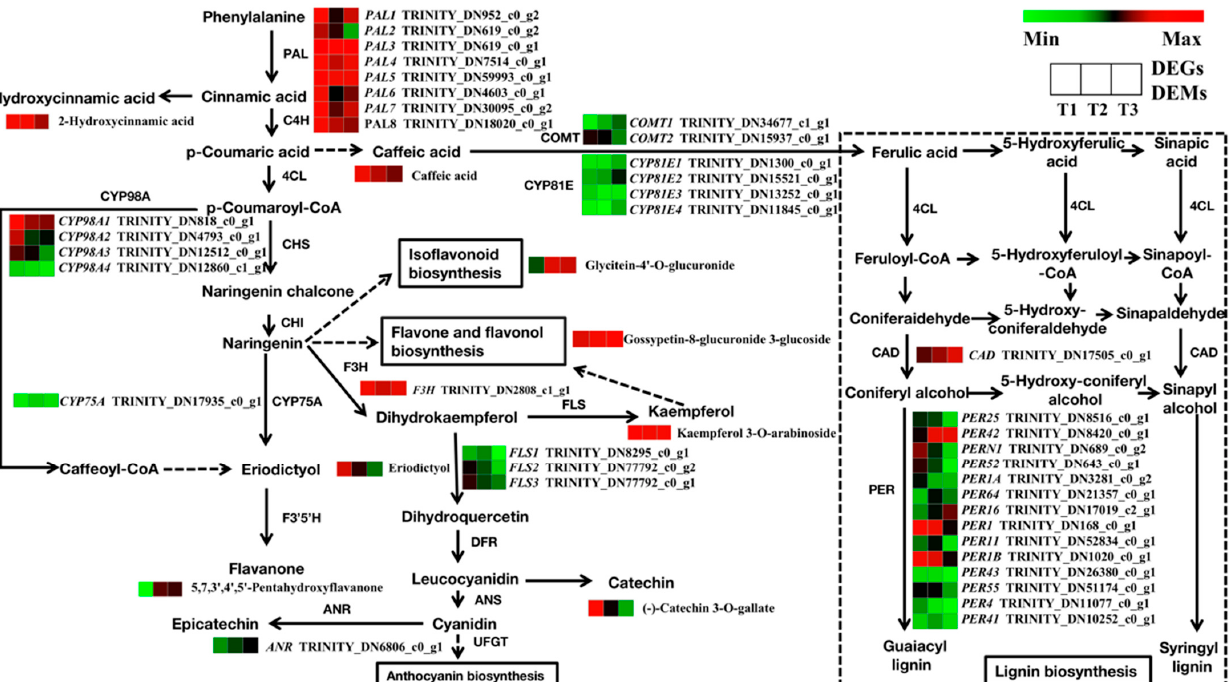
Figure 9. Regulatory network of flavonoid and phenylpropanoid biosynthesis in three different root samples. The color scale from green to red for the heatmap represents downregulated and upregu- lated expression. PAL, phenylalanine ammonia lyase; F3H, flavanone 3-hydroxylase; FLS, flavonol synthase; DFR, dihydroflavonol 4-reductase; ANR, anthocyanin in reductase; COMT, catechol-O- methyltransferase; CAD, cinnamyl-alcohol dehydrogenase.